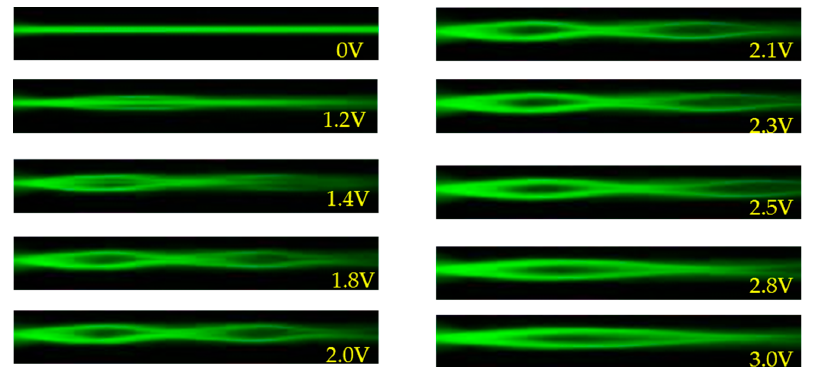
Figure 6. The intensity distributions of the incident beam introduced into the non-electrode area with the applied voltage from 0 to 3 V.